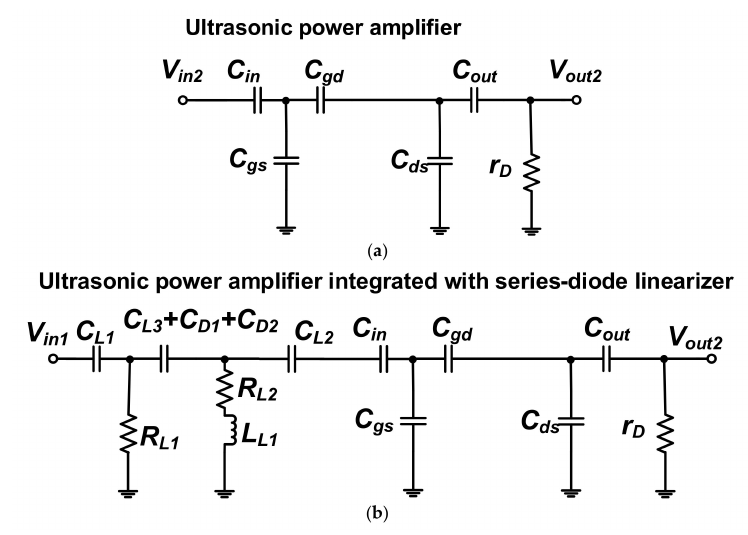
Figure 3. Equivalent circuit models of ( a ) the isolated ultrasonic power amplifier; ( b ) the ultrasonic power amplifier integrated with series-diode